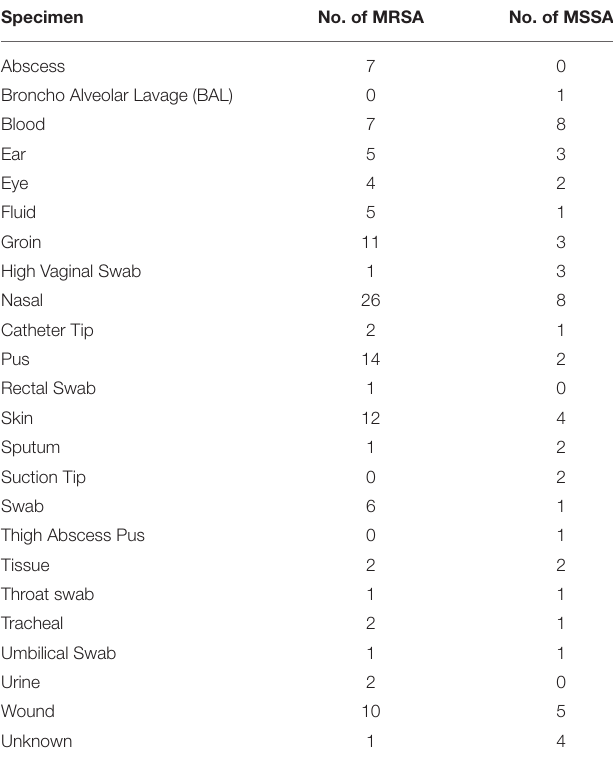
TABLE 2 | Sources of isolates in this study.